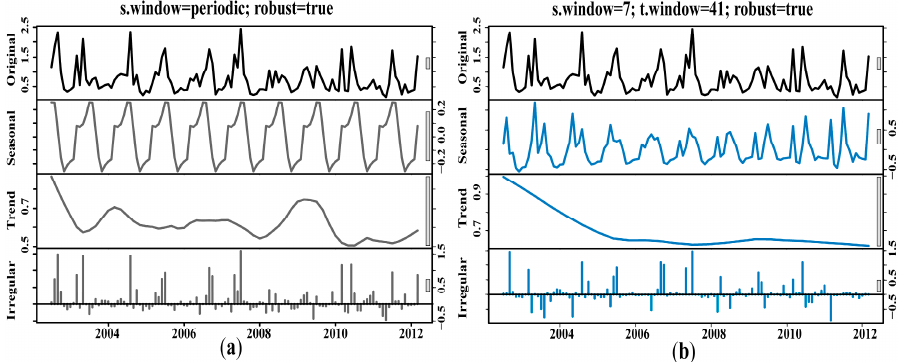
Figure 4. Decomposition plot of API 1 for Station C using: ( a ) stl() (grey); and ( b ) stl.fit() (blue).